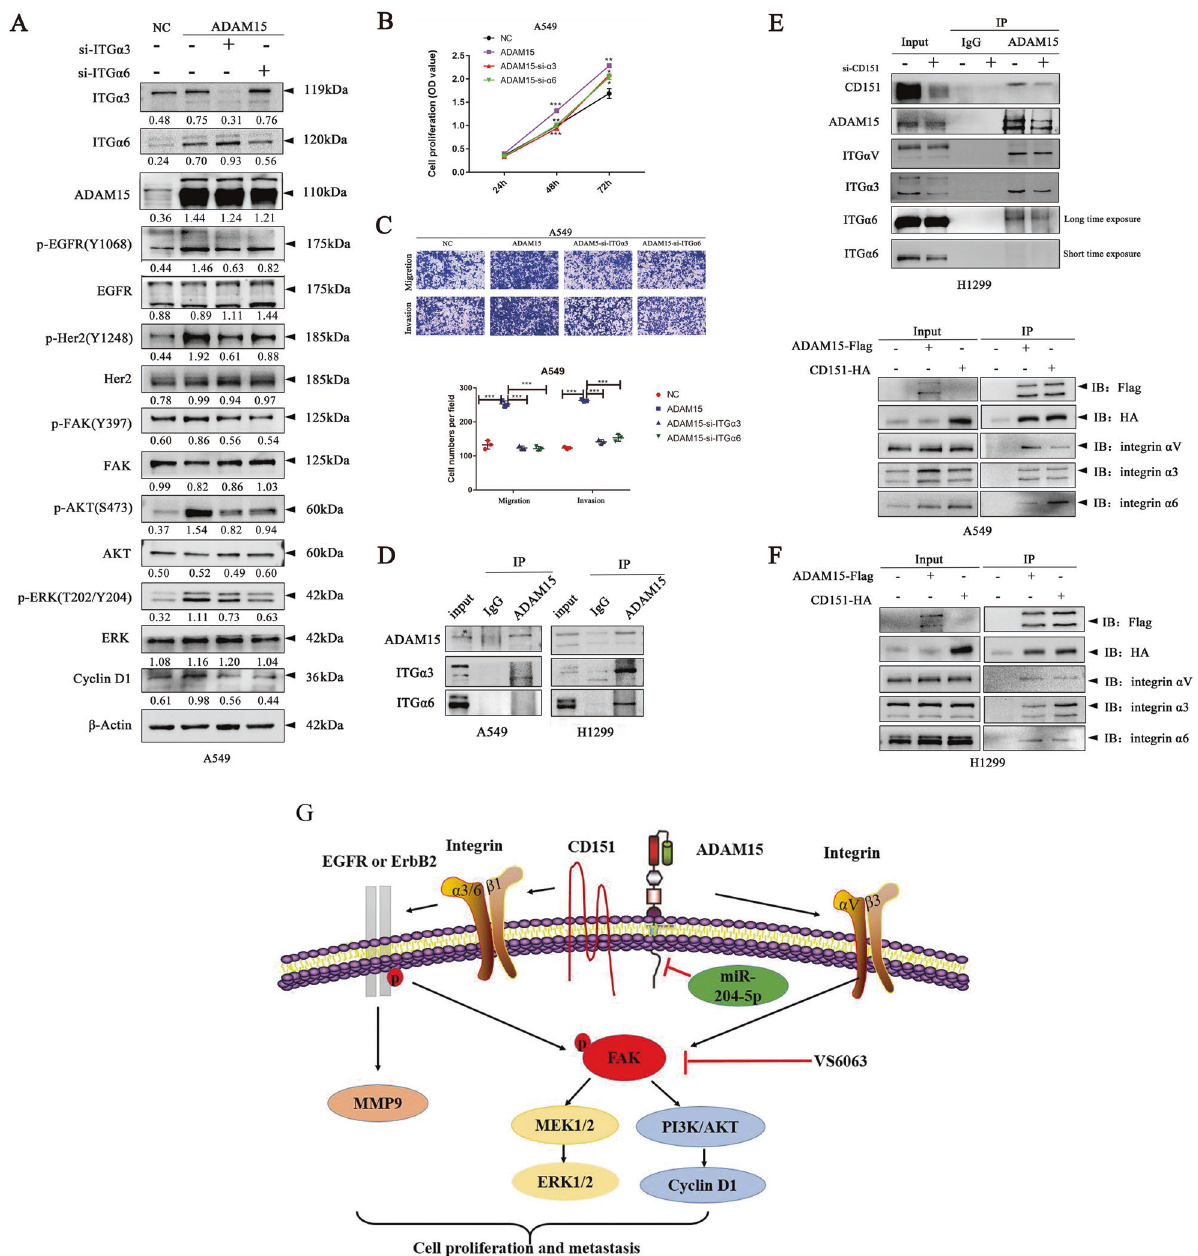
Fig. 8 ADAM15 affects the EGFR signalling pathway through integrin α 3/ α 6. A Control and ADAM15-overexpressing stable A549 cells were treated with the indicated siRNA (si- α 3/ α 6 compared with si-NC) followed by western blotting. β -actin was used as a loading control. B , C Control and ADAM15-overexpressing stable A549 cells were treated with the indicated siRNA (si- α 3// α 6 compared with si-NC), followed by CCK8 and Transwell assays. D Co-immunoprecipitation of ADAM15 and integrin α 3/ α 6 is shown. Protein was immunoprecipitated and detected from parental A549 and H1299 cells using a speci fi c monoclonal antibody. E Co-immunoprecipitation of ADAM15 and integrins were shown, protein were immunoprecipitation from lysates of control and CD151 knockdown H1299 cells using a speci fi c monoclonal antibody. F The Flag-tagged ADAM15 vector and HA-tagged CD151 vector were cotransfected into A549 and H1299 cells for 48 h. The protein were immunoprecipitated using agarose beads with anti-Flag antibody. * P < 0.05; ** P < 0.01; *** P < 0.001. G Schematic illustration of the functional roles of ADAM15, CD151 and integrin complexes in